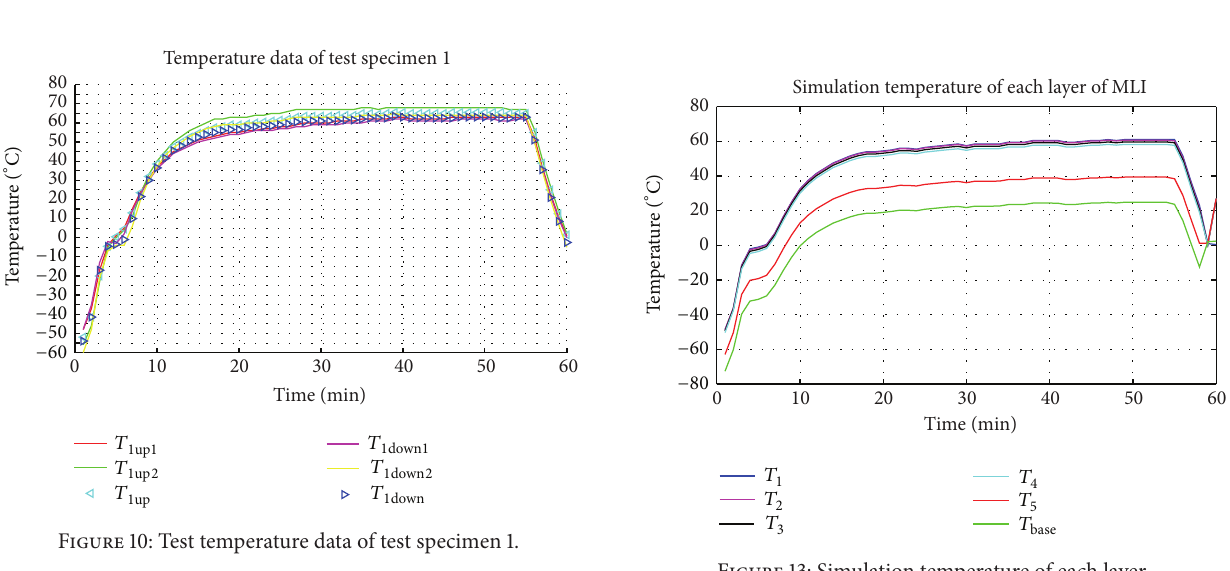
Figure 9: Test circuit diagram.